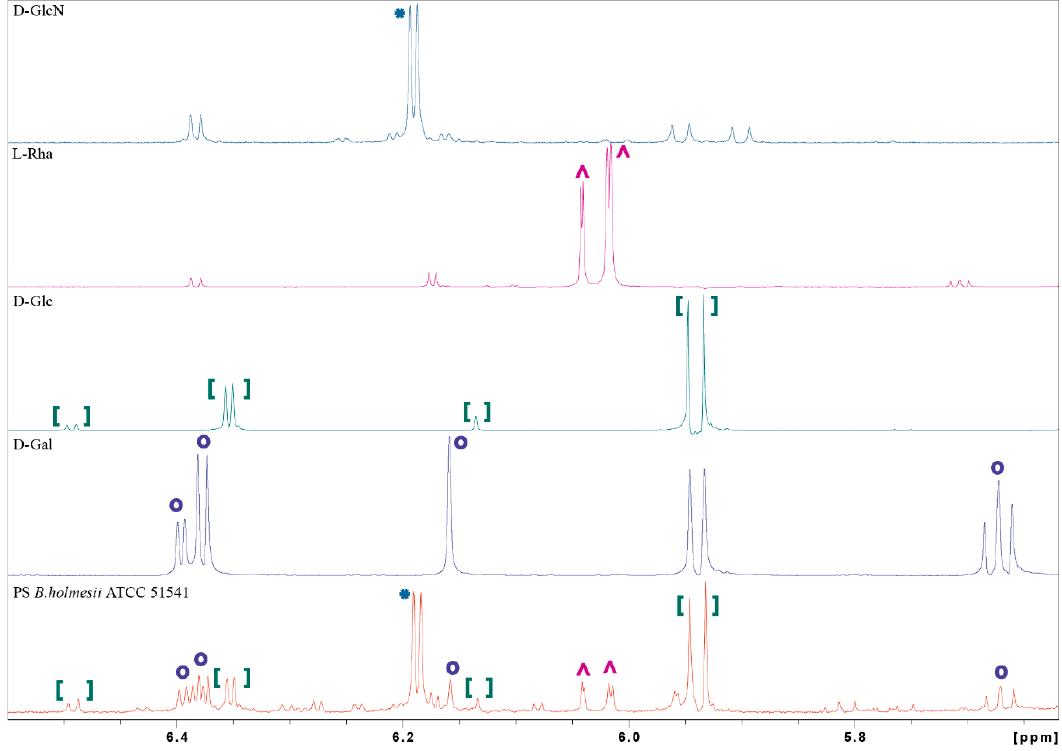
Figure 5. Comparison of NMR spectral profiles in the range of 5.5–6.5 ppm for O-(S)-2-methyl butyrate derivatives of monosaccharide standards and the B. holmesii O-PS hydrolyzate. The signs “o, *, ˆ, []” indicate the standard signals identified in the O-PS. The spectra were obtained for acetone-d6 solutions at 25 °C and calibrated to the internal reference of acetone-d5 ( δ 2.05 ppm).